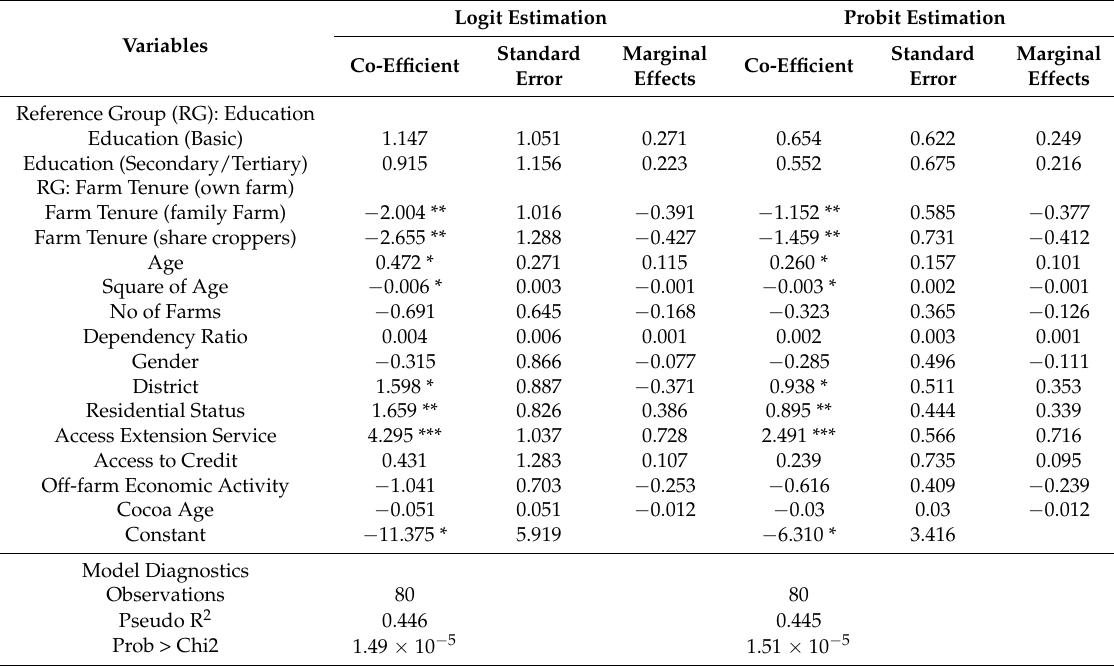
Table 7. Estimations of regression models for framing factors of CSA/Agroecology